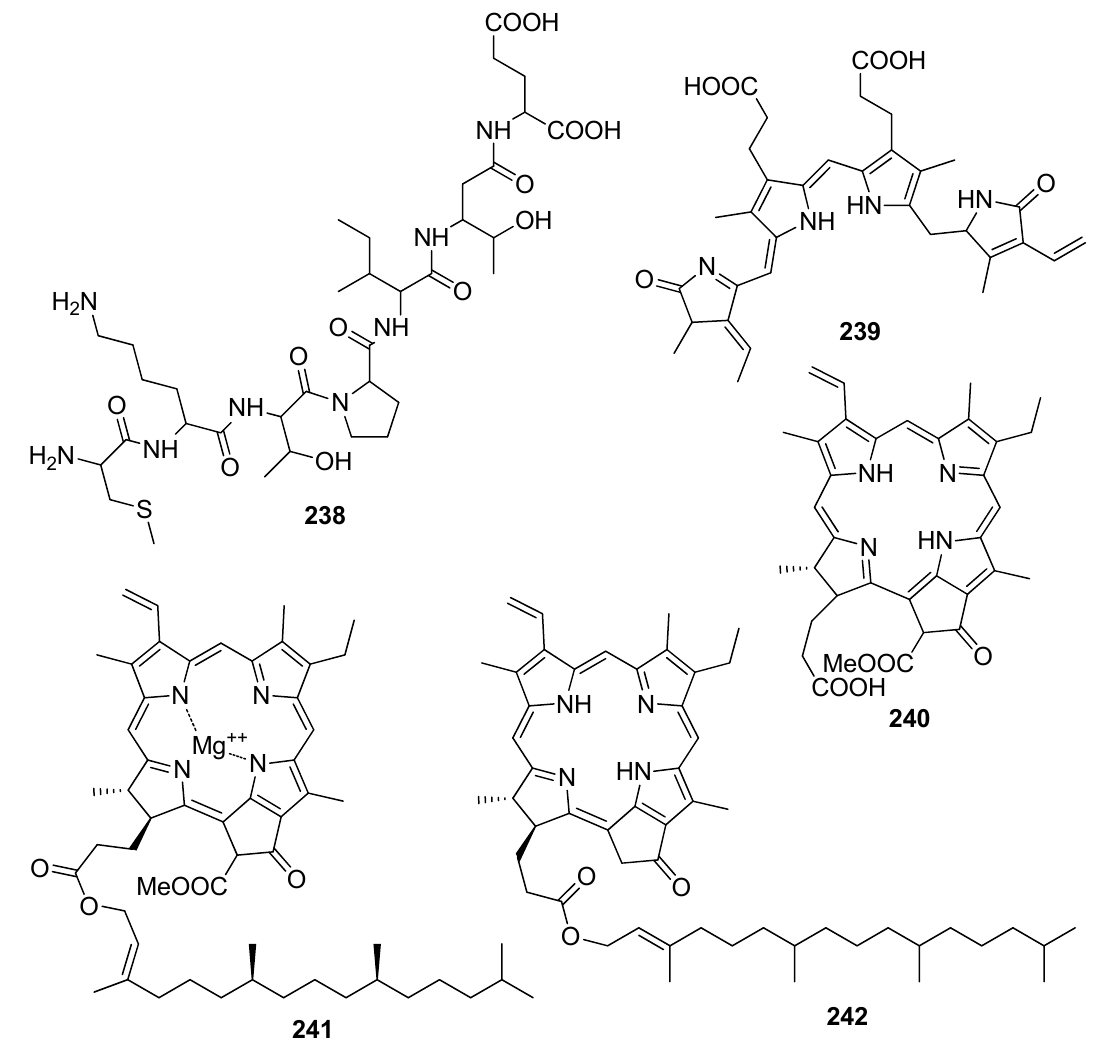
Figure 21. Chemical structures of compounds 238 – 242 .